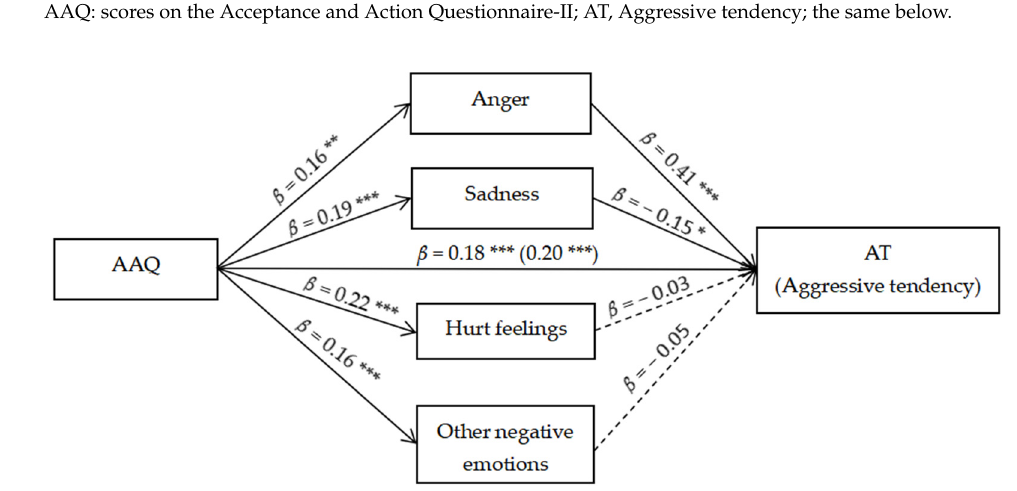
Figure 2. Parallel mediation model. * p < 0.05, ** p < 0.01, *** p < 0.001.